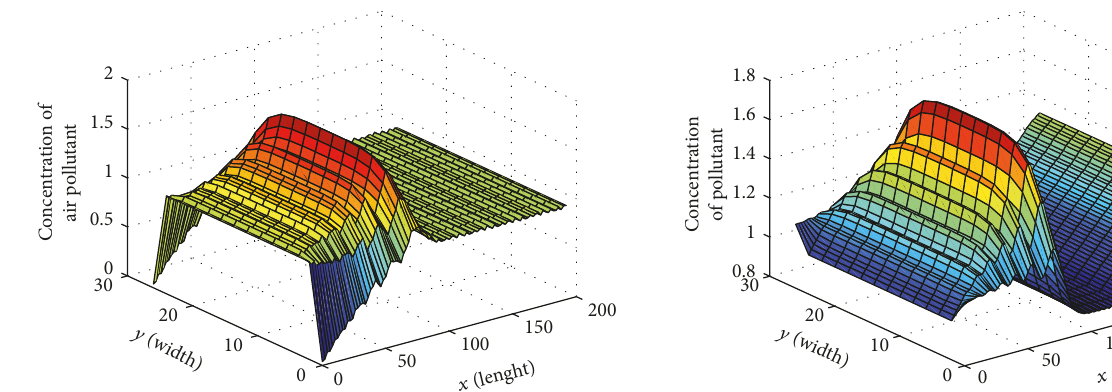
Figure 16: Surface plot of concentration of air pollutant levels for 𝑅 = 0.0 03 | sin (𝑥𝑡)| sec −1 .